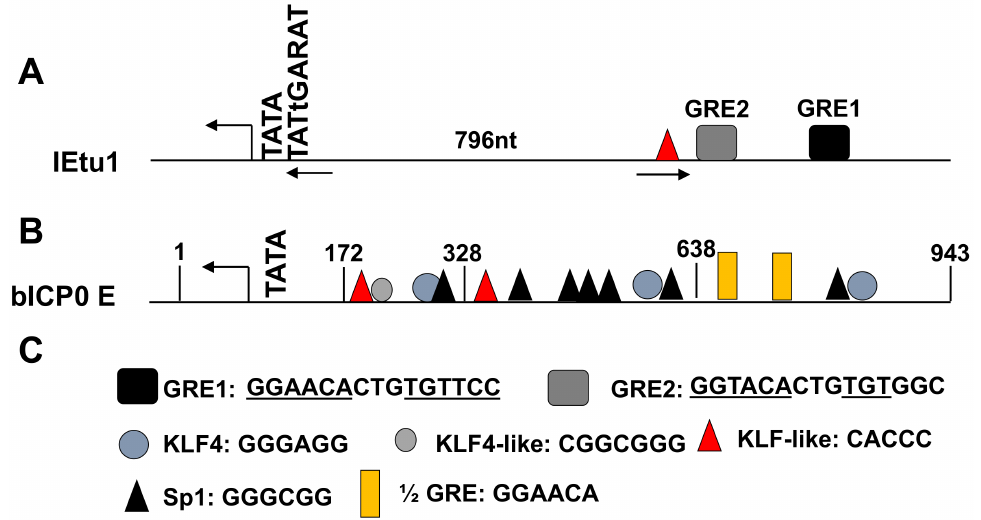
Figure 3. Schematic of BoHV-1 IEtu1 and bICP0 E promoters. ( A ) Key features of the IEtu1 promoter are depicted. The site of transcription initiation is indicated by an arrow immediately downstream of the TATA box and TATGARAT motif. The KLF-like CACCC and two GREs are also indicated. The TATA box is separated from GRE2 by 796 nucleotides. ( B ) Key features of the bICP0 E promoter are depicted. The site of transcription initiation is indicated by an arrow immediately downstream of the TATA box. The three enhancer domains are indicated: EP-328 (nucleotides 172 to 328), EP-638 (nucleotides 328 to 638), and EP-943 (nucleotides 638 to 943). Relative positions of Sp1, KLF4, and KLF-like sites are indicated. ( C ) Legend of transcription factor binding sites and consensus nucleotide sequences for binding